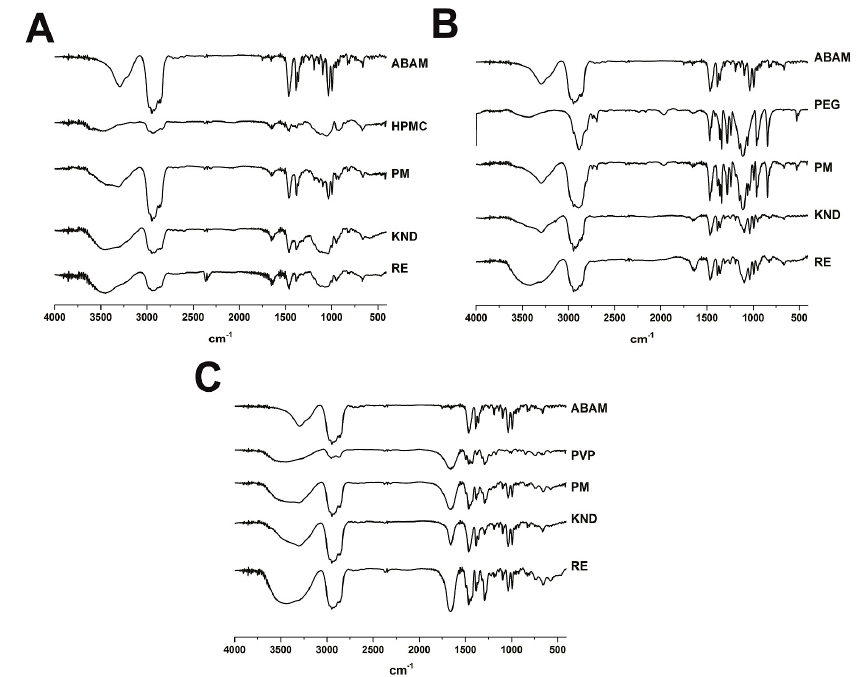
Figure 1. FTIR spectra of ABAM, HPMC and solid dispersions of ABAM with HPMC ( A ) FTIR spectra of ABAM, PEG-6000 and solid dispersions of ABAM with HPMC ( B ) and FTIR spectra of ABAM, PVP K-30 and solid dispersions of ABAM with PVP-K30 ( C ).